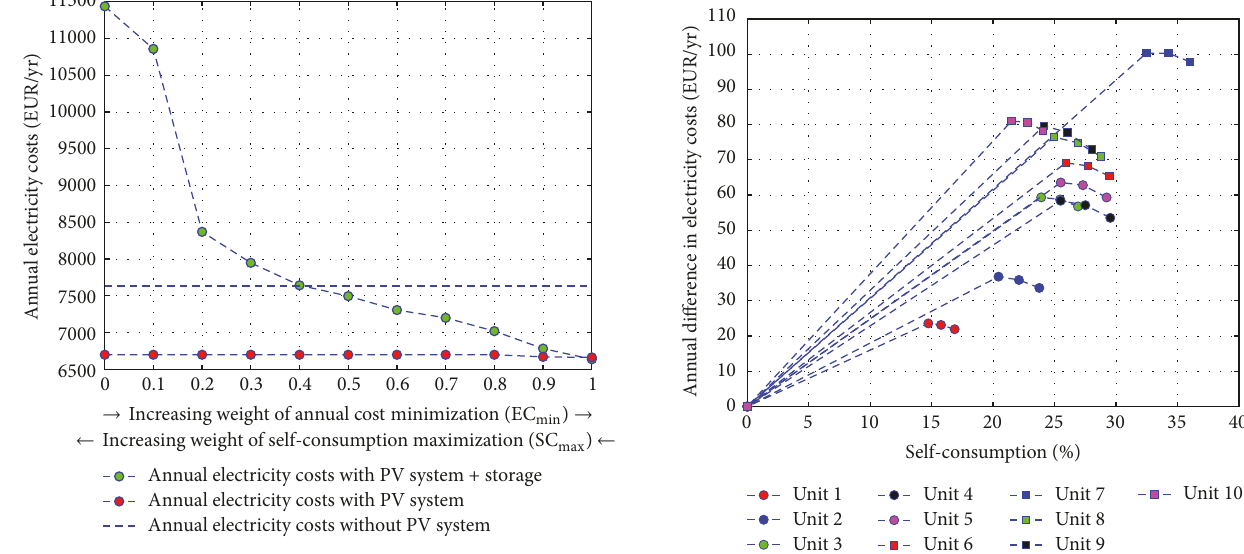
Figure 17: German retail electricity prices, consideration of indi- vidual apartments: annual differences in electricity costs with and without a PV